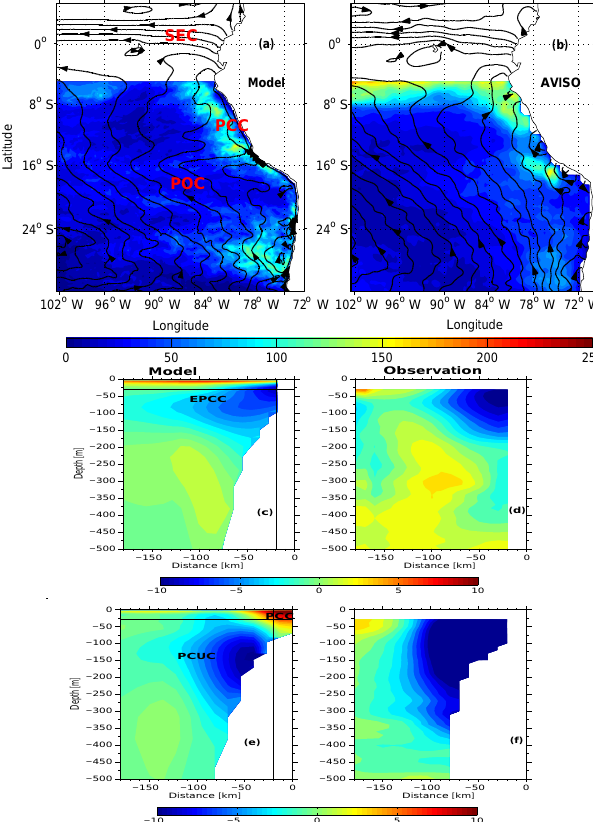
Figure 1. Annual mean surface height (contour every 6cm) over- laid on eddy kinetic energy (cm − 2 s − 2 , colour), corresponding to (a) model simulation and (b) AVISO observation. Vertical distribu- tion of simulated (c, e) and observed (d, f) mean alongshore veloc- ity (cms − 1 ), averaged over 3–6 ◦ S (c, d) and at around 12 ◦ S (e, f) . The black lines in (c, e) are the upper and onshore limits of the observed velocities. The observed velocities in (d, f) were provided by IMARPE and described in detail by Chaigneau et al. (2013).